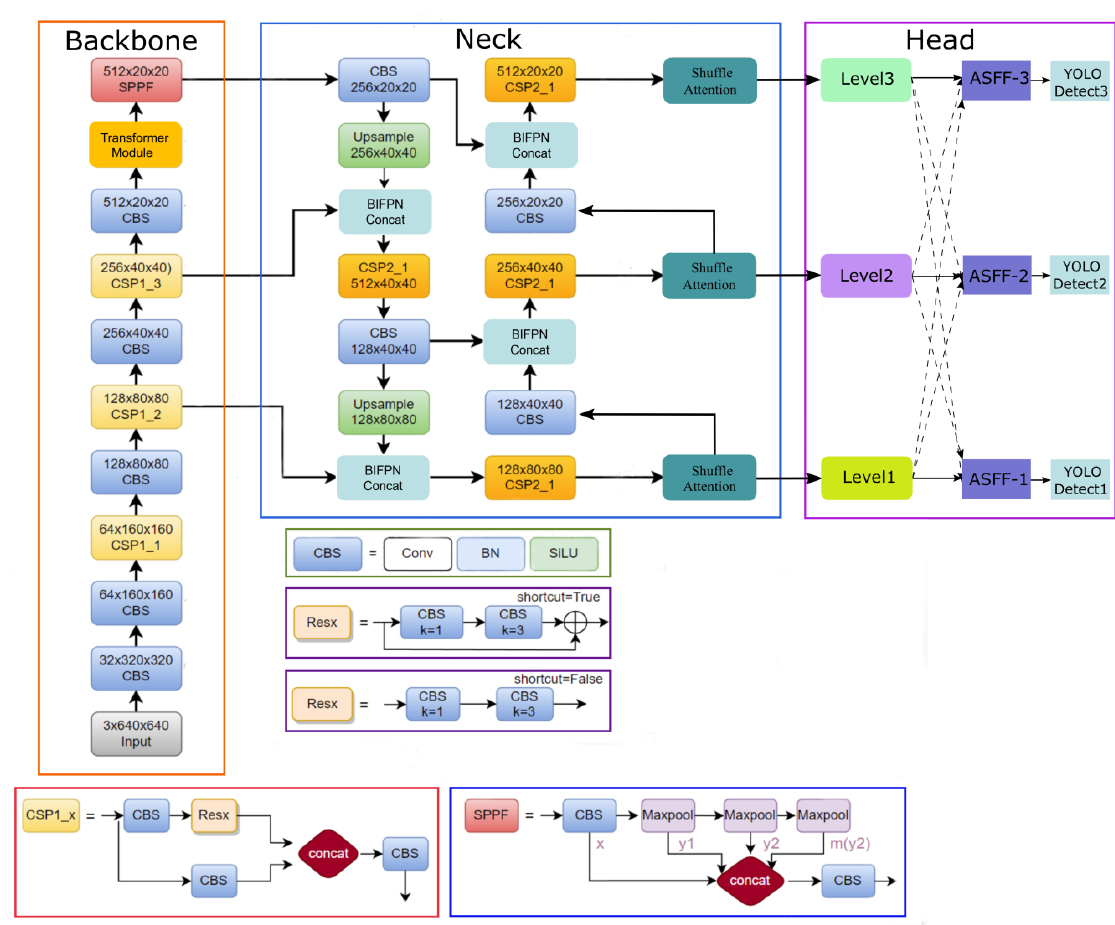
Figure 5. The structure of our improved model: TSBA-YOLO.